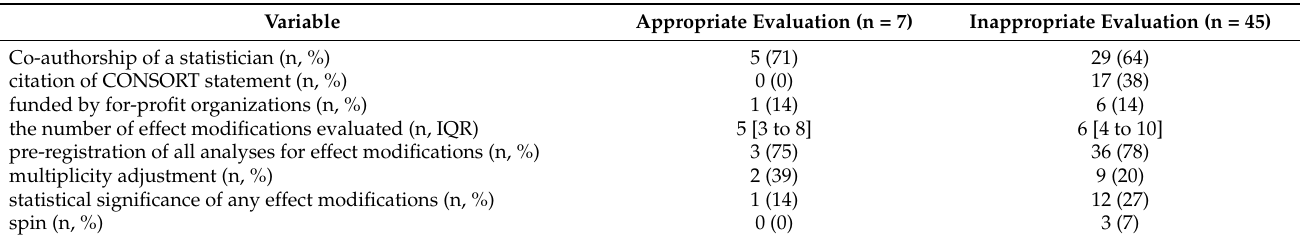
Table 2. Summary of exploratory